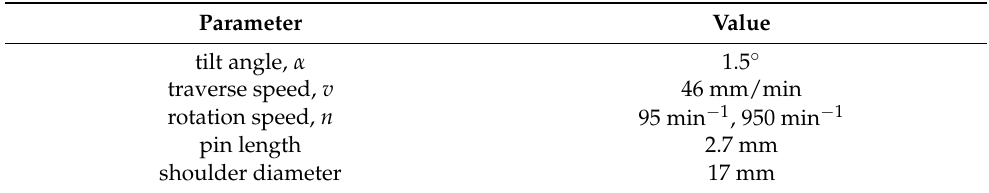
Table 2. Friction stir processing